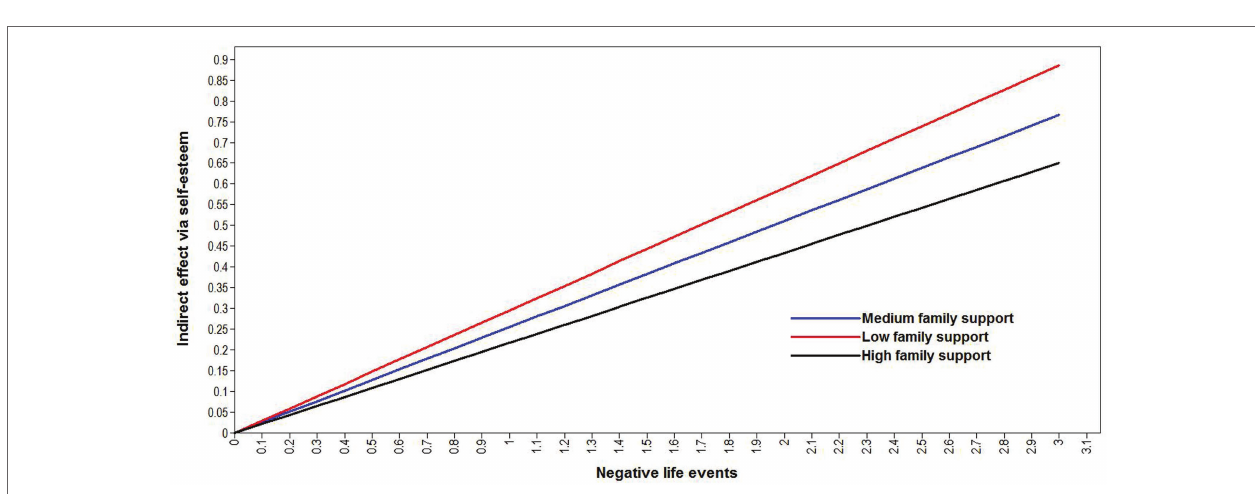
FIGURE 4 | The conditional indirect effect of negative life events on antisocial behavior tendencies via self-esteem for each combination of low, medium, and high family support values. (High family support: family support values above mean + 1 SD; medium family support: family support values of mean ± 1 SD; low family support: family support values below mean − 1